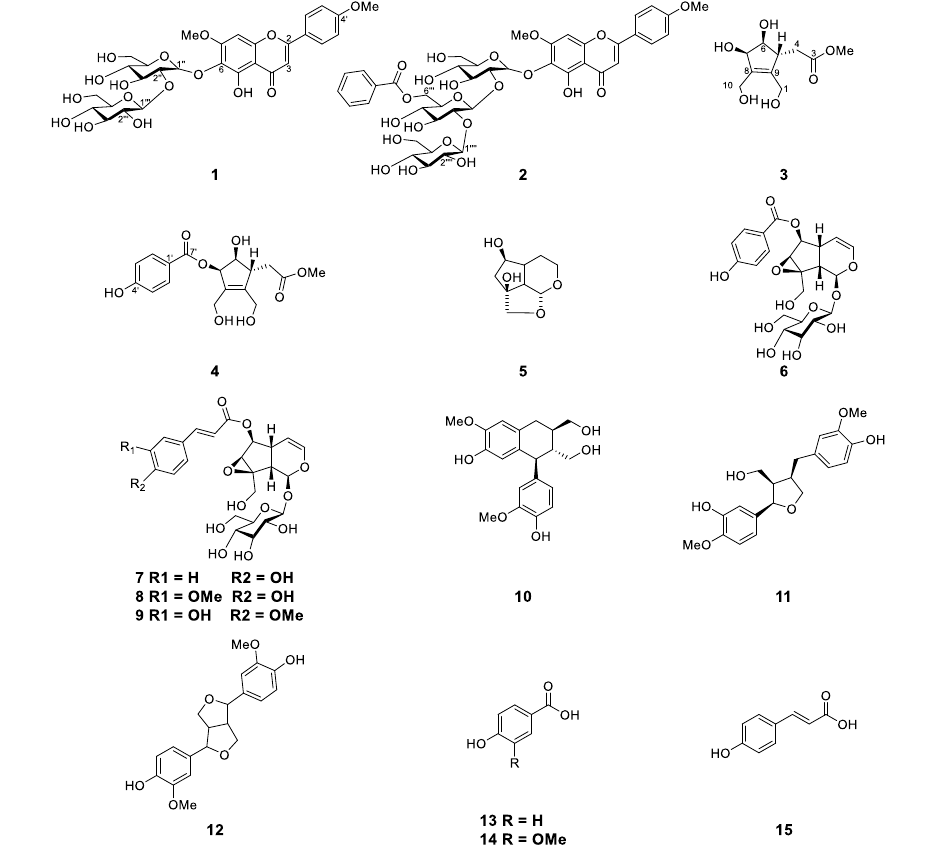
Figure 1. Chemical structures of compounds 1 – 15 .